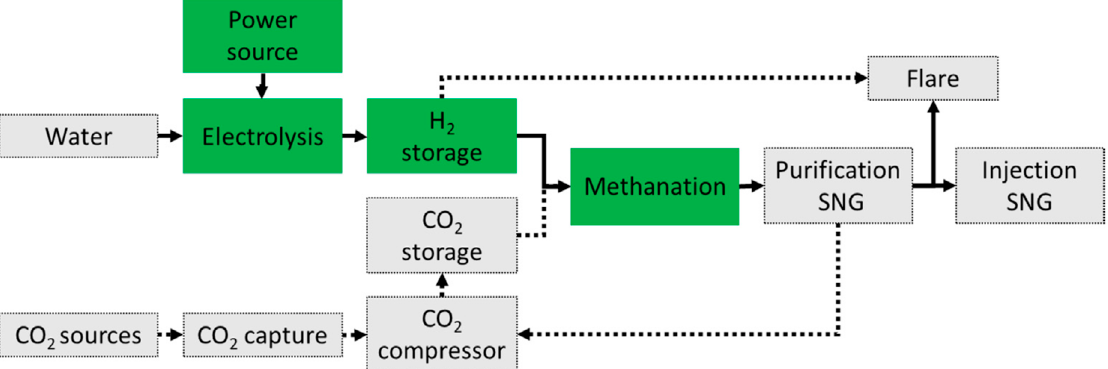
Figure 9. Power-to-Gas (PtG) plant scheme as implemented for the production of synthetic natural gas from CO 2 and green H 2 . Reproduced from ref. [90], open access, Copyright 2020 Elsevier.